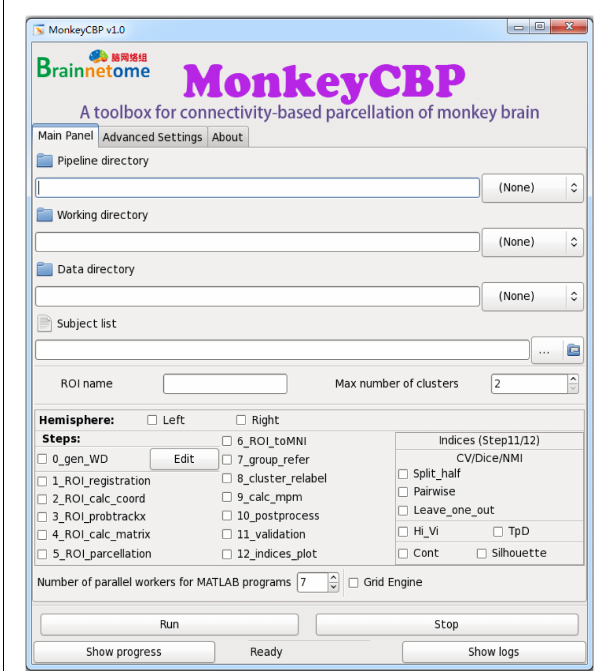
FIGURE 5 | Graphical user interface (GUI) version of MonkeyCBP. The “Main Panel” menu including settings for input files and directories as well as configuration information. The “Advanced Settings” menu including advanced parameters for the command path and file as well as some specific parameters. The “About” menu displays the information relevant to the developer and license. At the bottom of the interface are several fixed buttons designed for users to control the start-up and shutdown of tasks, as well as to check the running progress and processing logs in real time. In addition, MonkeyCBP GUI version also supports parallel computing, but it is just single-ROI oriented, which is not like the CLI version that could parcellate multiple brain regions at the same